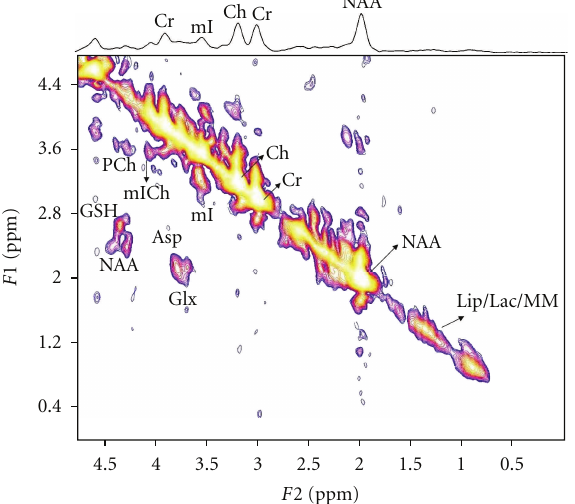
Figure 1: The axial MRI with MRS voxel location of a 64 years old HCV+ patient.